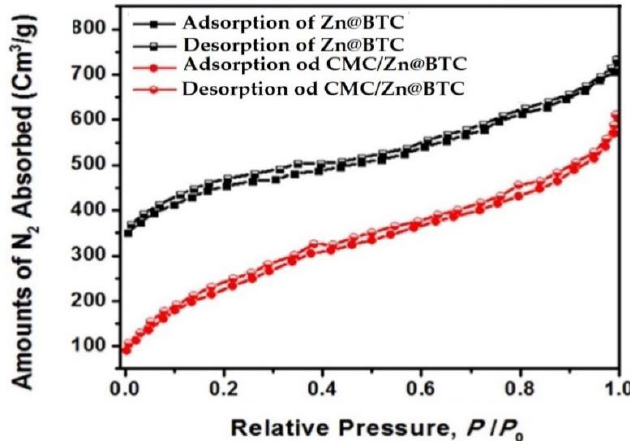
Figure 5. N 2 adsorption – desorption isotherms of Zn@BTC and CMC/Zn@BTC.